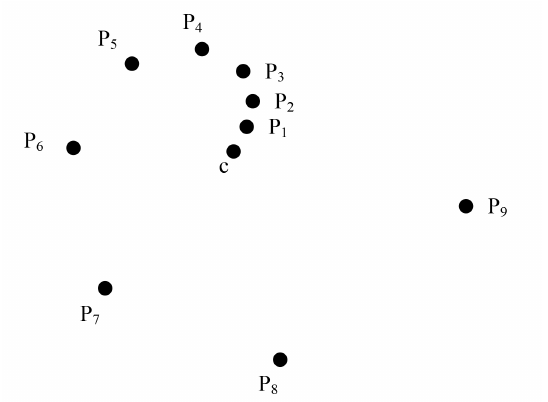
Figure 5. Desired non-uniform and non-circular formation on a